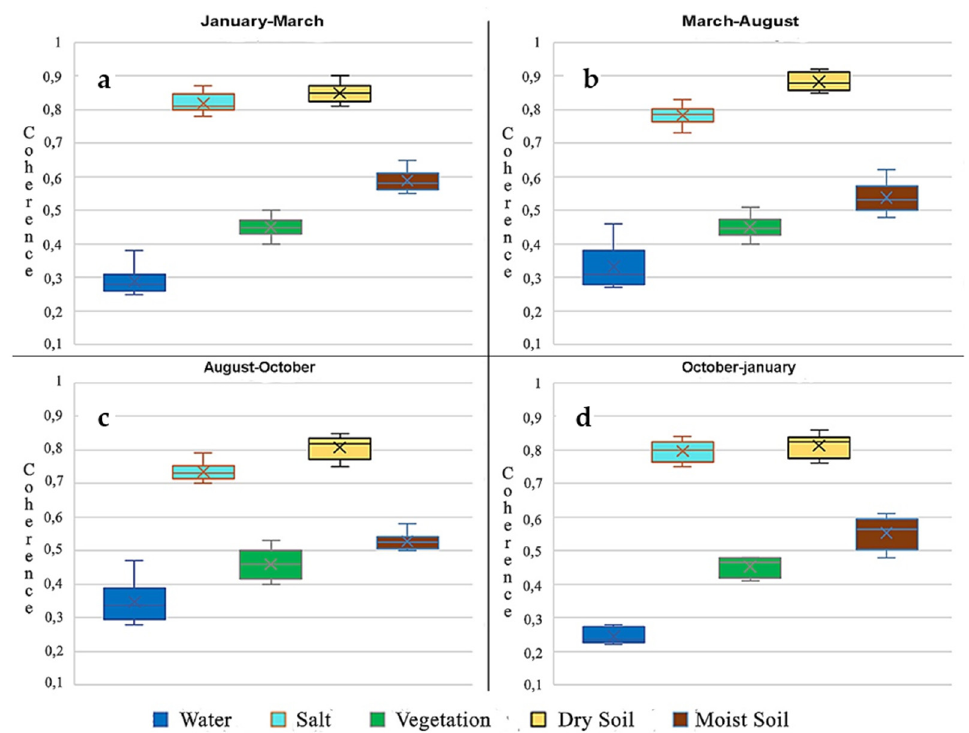
Figure 8c. Finally, the October to February values, when the lake started to fill with the onset of rains and reached its maximum levels, are shown in Figure 8d.